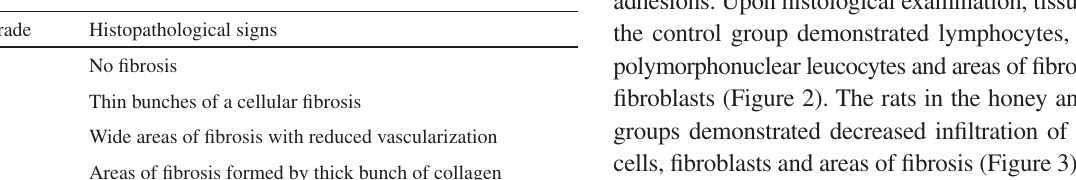
Table 2 - Scale for microscopic assessment of fibrosis 1